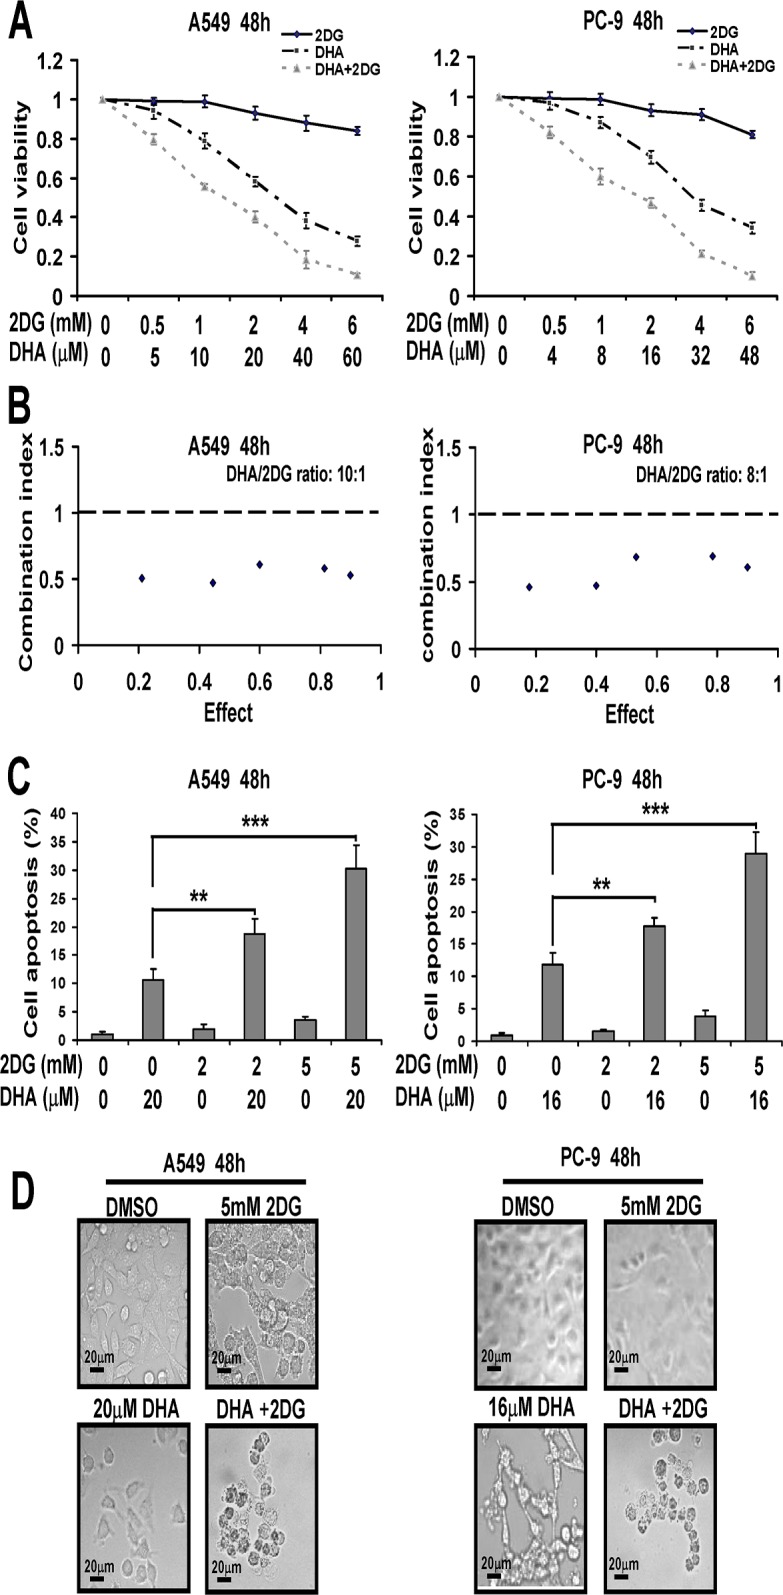
DHA combined with the glycolysis inhibitor decreases cell viability and induces apoptosis in NSCLC cells.(A) Inhibitory effects of DHA combined with 2-Deoxy-D-glucose (2DG) on cell proliferation in A549 and PC-9 cells. Cells were treated with indicated concentrations of DHA and 2DG for 48 h. Cell growth inhibition activity was assessed by MTT. (B) The dose–response curve of each drug was determined and combination index (CI) values for DHA/2DG concentration ratios (10:1 in A549 cells, 8:1 in PC-9 cells) were calculated according to the Chou–Talalay’s method at the 48 h time point, with the biological response being expressed as the fraction of affected cells. Diamond symbol designate the CI value for each fraction affected (effect). CI < 1, CI = 1, CI > 1 indicate synergistic, additive and antagonistic effects, respectively. The effect ranges from 0 (no inhibition) to 1 (complete inhibition). The data are representative of three independent experiments. (C) Influence of DHA combined with 2DG on apoptosis in A549 and PC-9 cells. Cells were treated with indicated concentrations of DHA and 2DG for 48 h. Cell apoptosis was assessed by Annexin V-FITC/PI staining assay. Data were mean ± SD (n = 3). *, P < 0.05; **, P < 0.01; ***, P < 0.001. (D) A549 and PC-9 cells were treated with indicated concentrations of DHA and 2DG for 48 h. Images were recorded using a digital camera with 1280×1280 pixels resolution. Magnification 400. Scale bar: 20 μm.